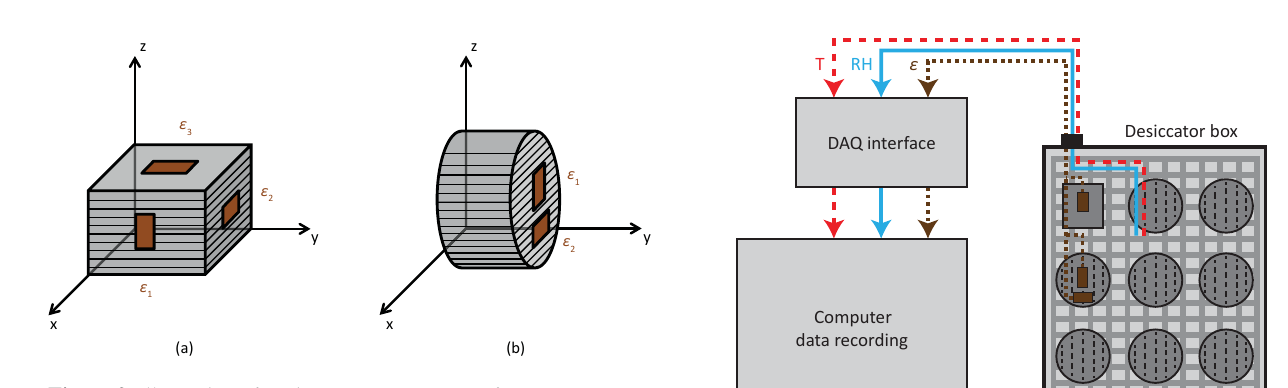
Figure 2. Illustration of strain gauge arrangement for measurements of principal strains: (a) on a cubic Opalinus Clay specimen (S4) measuring all principal strains individually; (b) on a cylindrical Brazilian test specimen (E19) measuring only two principal strains.